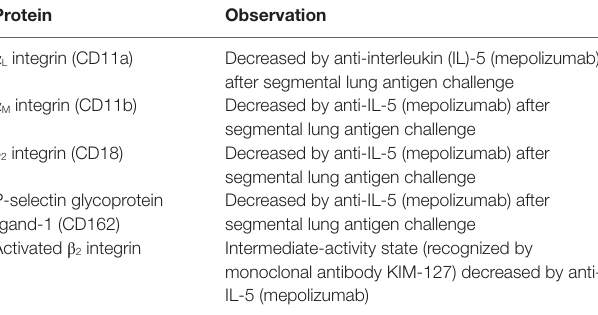
TAbLe 3 | Eosinophil surface proteins reported to respond to intervention in